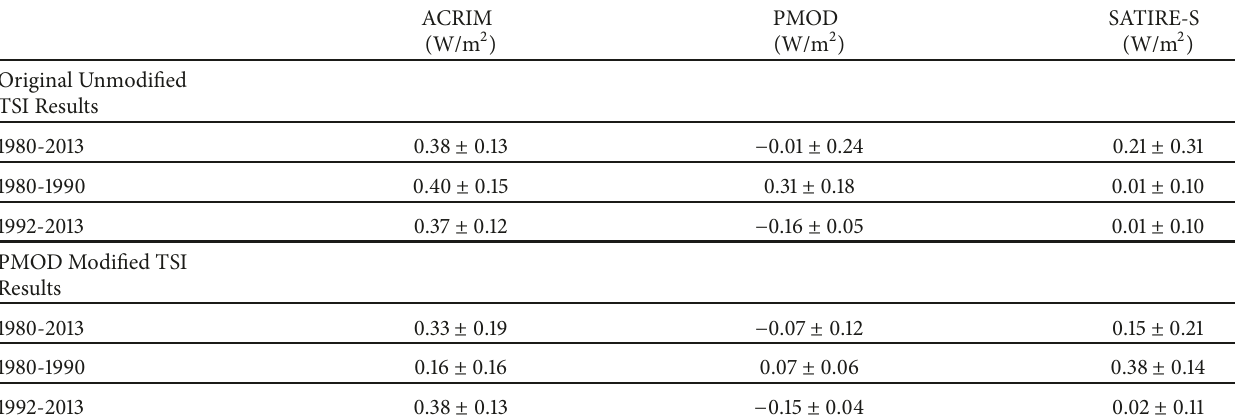
Table 2: Mean and standard deviation of the curves depicted in Figure 4 in the reported time intervals.